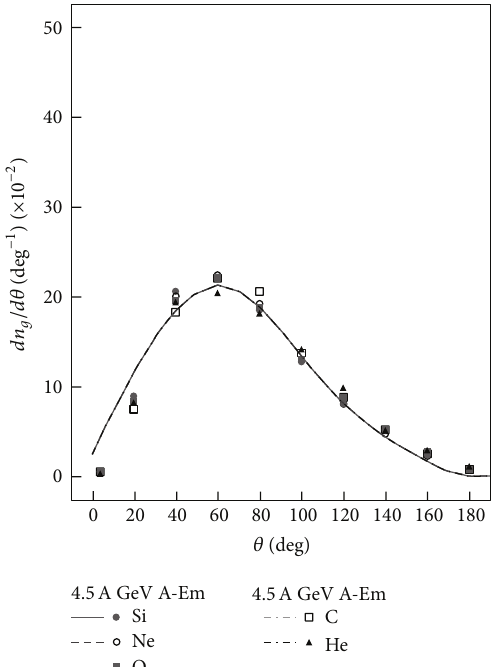
Figure 6: Angular distributions of grey particle produced in 4 He- (solid triangle), 12 C- (open square), 16 O- (solid square), 22 Ne- (open circles), and 28 Si- (solid circles) Em collisions at (4.1–4.5) AGeV/c. The symbols represent the experimental data. Capone the curves are our calculated results by multisource thermal